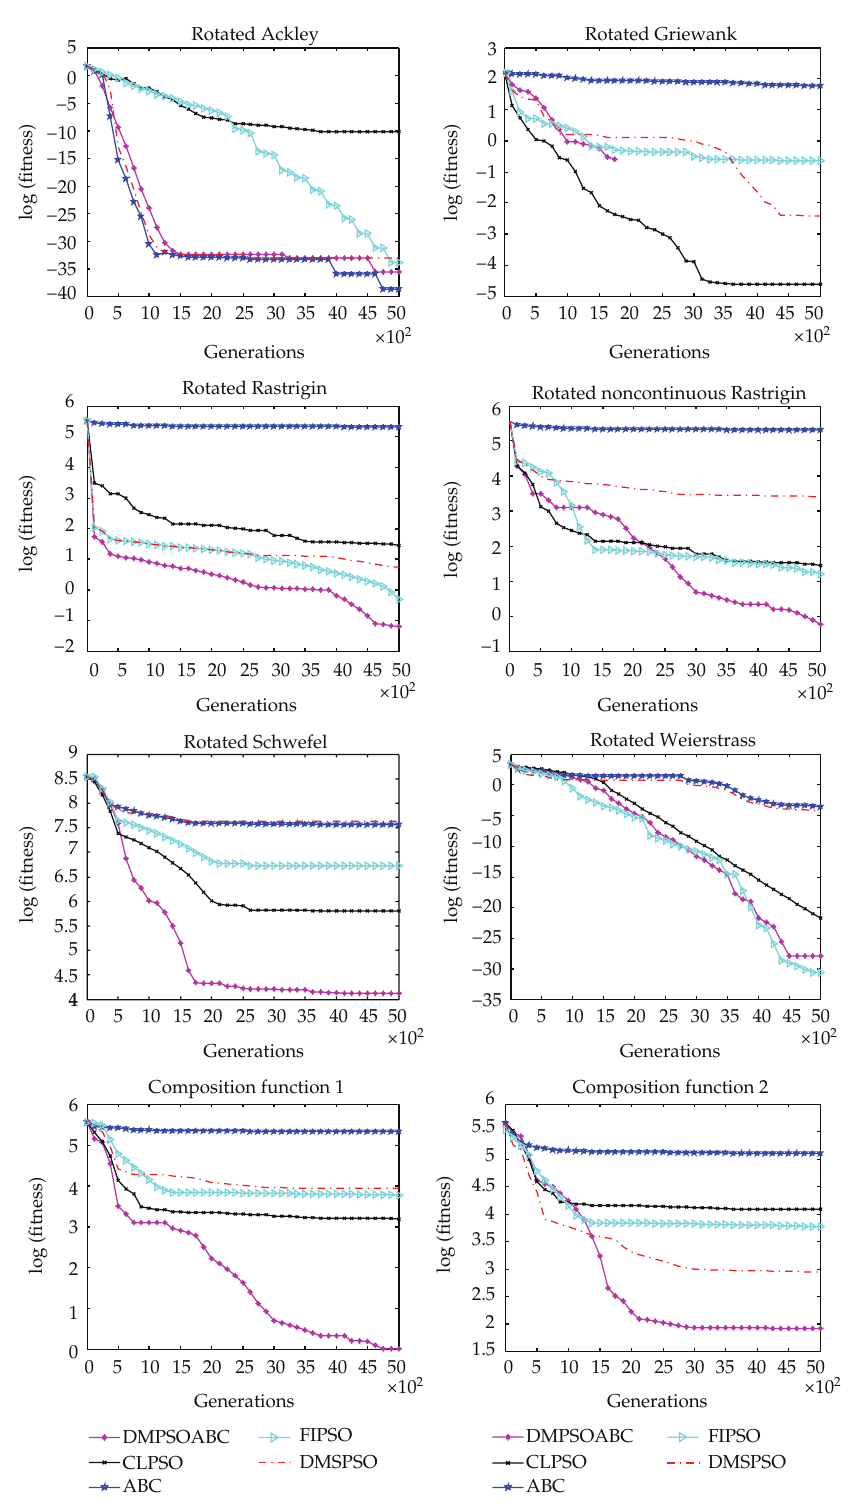
Figure 4: The median convergence characteristics of 30-D test